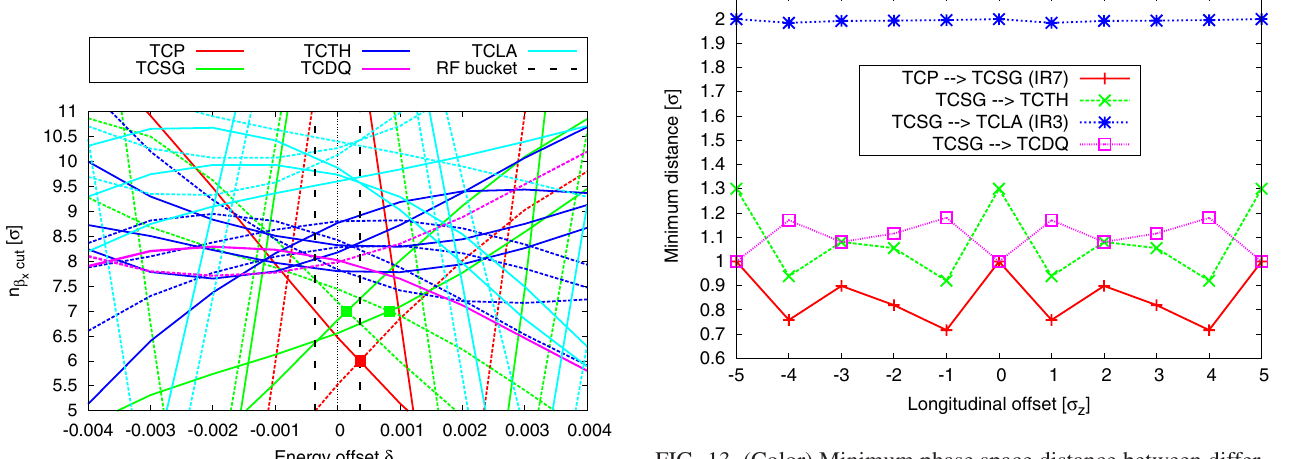
FIG. 13. (Color) Minimum phase space distance between differ- ent groups of collimators: TCP and TCSG (red); TCSG and TCTH (green); TCSG and TCLA (blue); TCSG and TCDQ (magenta).